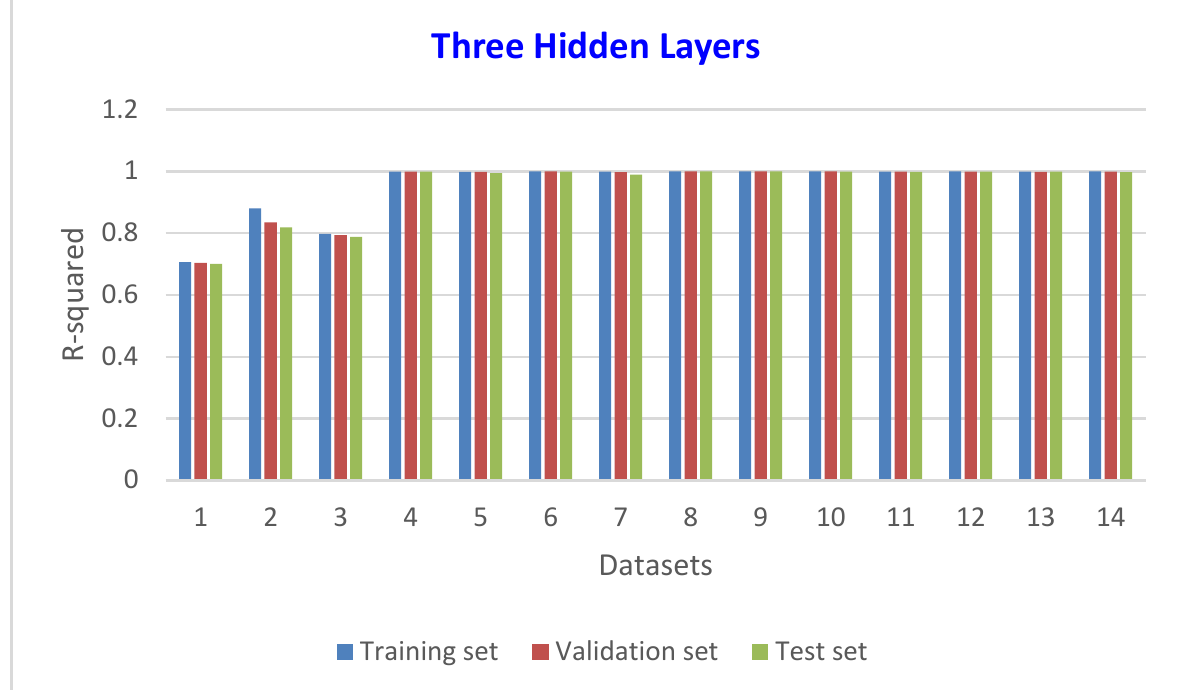
Figure 8. R-squared for the neural network model with three hidden layers.